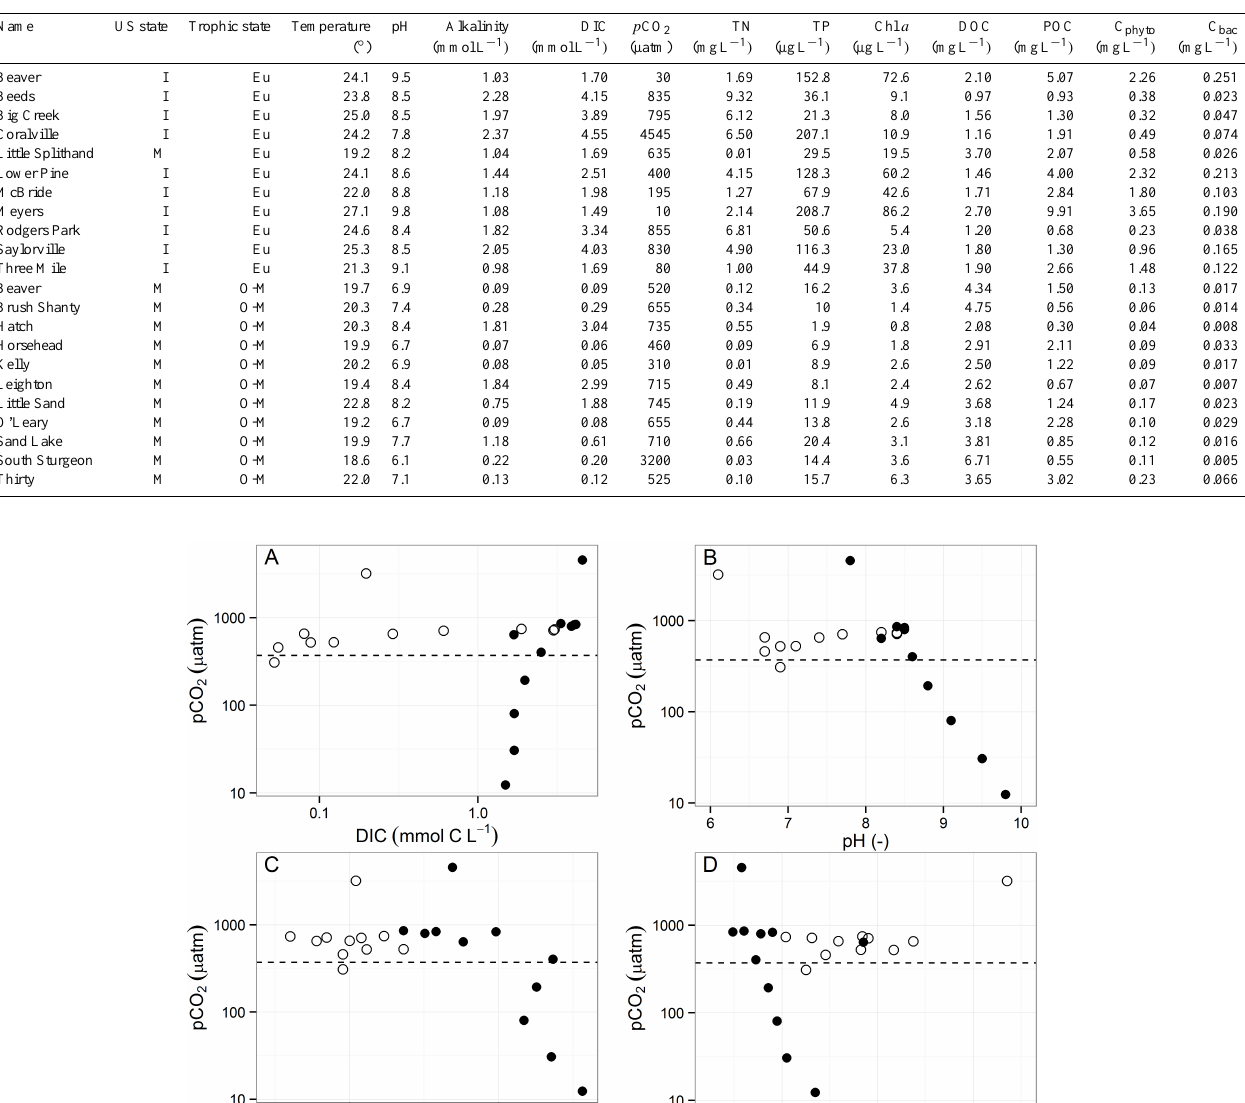
Table 1. Limnological characteristics of the sampled lakes. p CO 2 was determined from temperature, DIC, and pH. C phyto is the average of chl a and fatty acid based phytoplankton biomass. C bac is fatty acid derived bacteria carbon biomass. I, Iowa; M, Minnesota; TN, total nitrogen; TP, total phosphorus.